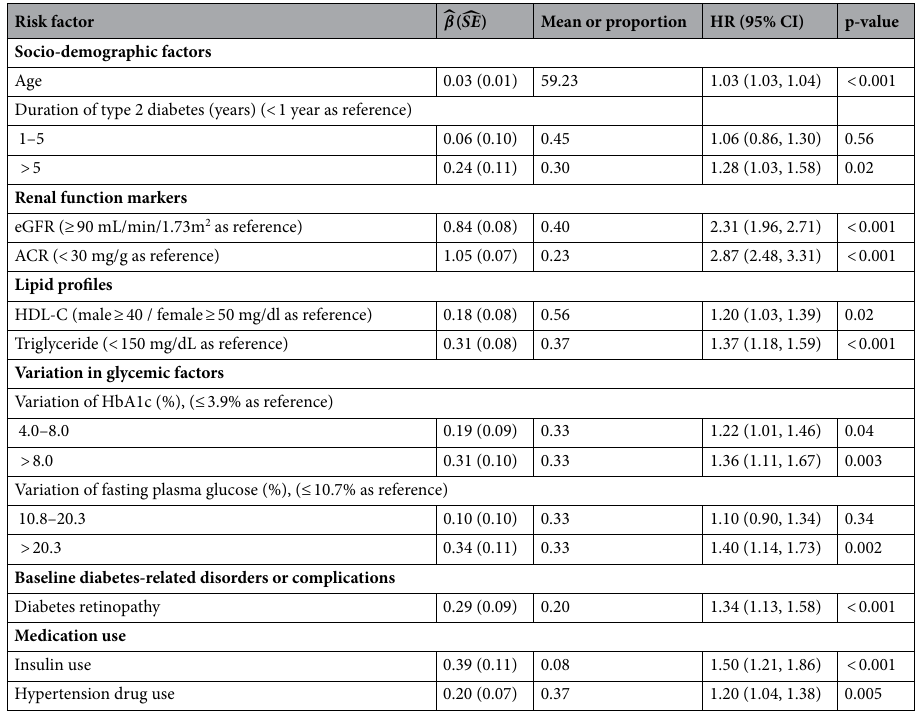
Table 2. Parameter estimates of regression coefficient and the means or proportions of predictors for CKD from the final multivariate Cox’s proportional hazards model. CKD chronic kidney disease, eGFR estimate glomerular filtration rate, ACR albumin to creatinine ratio, HDL-C High-density lipoprotein, variation of FPG variation of fasting plasma glucose, HR hazard ratio, CI confidence